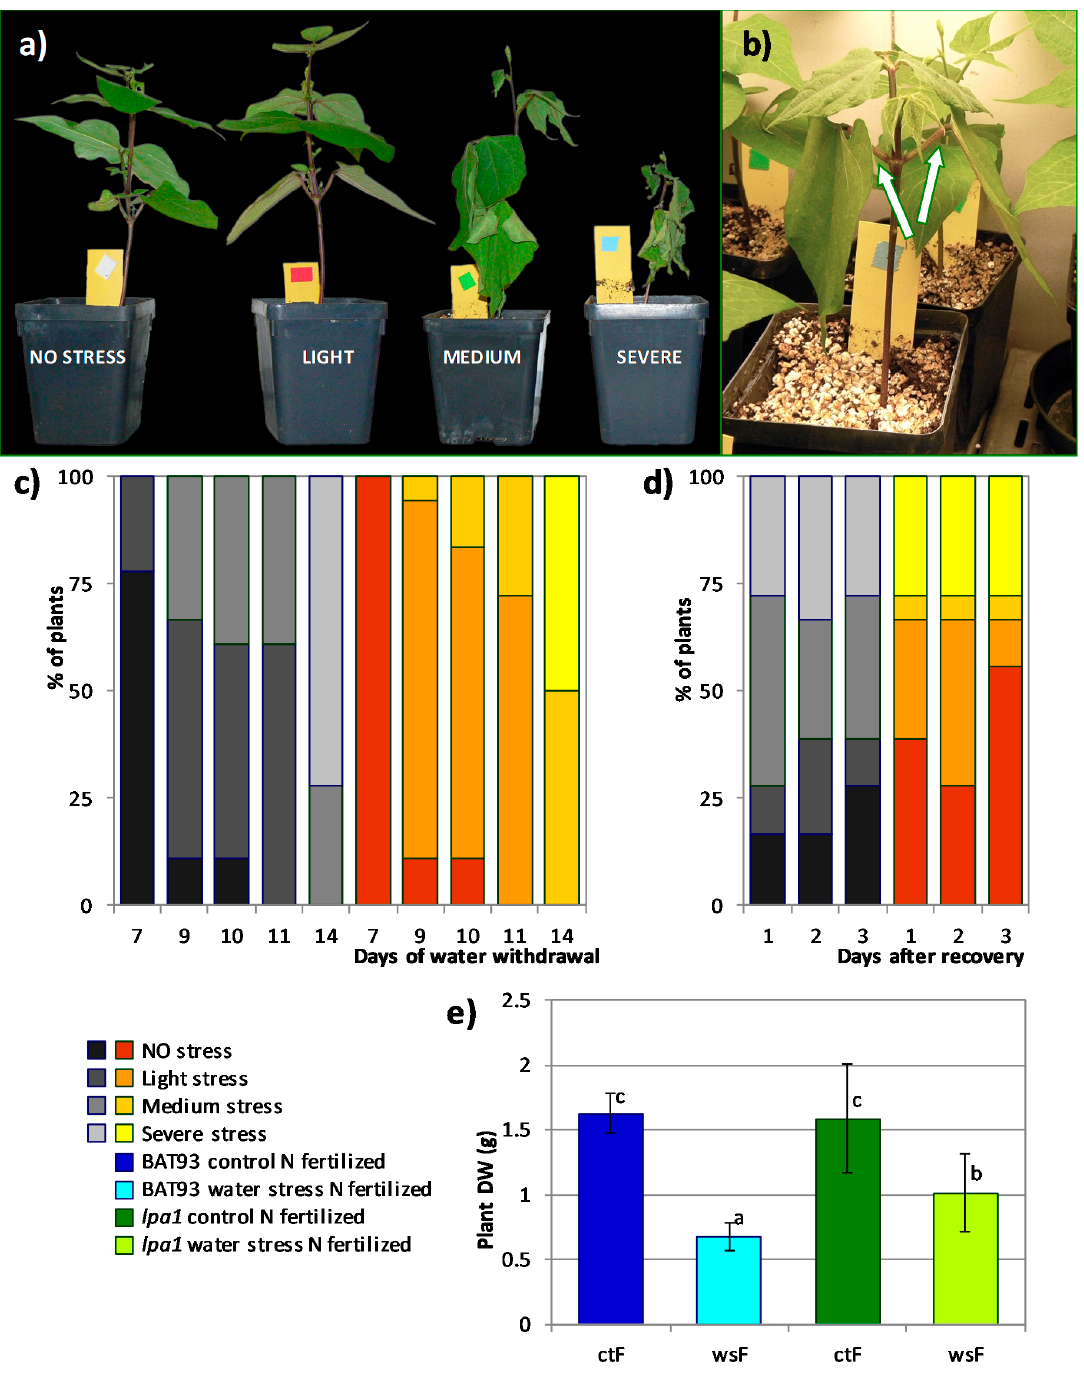
Figure 3. Effect of water withdrawal on two weeks old fertilized wild type (wt) and lpa1 plants and response to one week of recovery. (a) Plants were classified, according to gradual level of water stress, into four phenotypical classes, showing no stress, light, medium or severe stress symptoms, as shown in the picture for wt plants as example. (b) Detail of a lightly stressed plant, showing epinastic cotyledonary leaves. (c) The percentage distribution of plants during the stress period, categorized in the four classes shown in ( a ) is indicated with darker to light colored bars, for wt (grey) and lpa1 (orange) plants. (d) Plant phenotype during the first three days of recovery period, recording similar stress symptoms as those described in (a) and (c) . (e) Dry weight of control (ctF) and water stressed (wsF) plants at the end of one week of recovery, blue and green indicate wt and lpa1 plants, respectively. Equal lowercase letters correspond to equal mean for ANOVA with Tamhane T2 post hoc test. Bars represent ± SD.